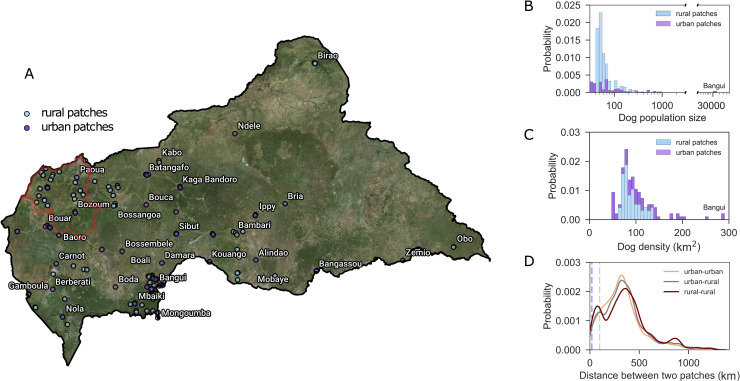
Modeled domestic dog population in Central African Republic.A) Geographical distribution of the predicted dog subpopulations divided in rural (light blue) and urban (violet) patches. The red shaped area indicates the Ouham-Pendé prefecture. B) Probability distribution of the estimated dog population size per patch in rural (light blue) and urban (violet) patches. C) Probability distribution of the estimated dog population density per km2 per patch in rural (light blue) and urban (violet) patches. D) Probability distribution of the distance between any two patches in the metapopulation network, whether connecting two urban patches (orange), two rural patches (dark red), a urban with a rural patch (black). The two dashed vertical lines indicate the separation between short, medium, and long-range movements. The satellite map was generated using data sourced from OpenStreetMap (OpenStreetMap contributors) and created through QGIS software (QGIS Development Team (2019). QGIS Geographic Information System. Open Source Geospatial Foundation Project. http://qgis.osgeo.org).